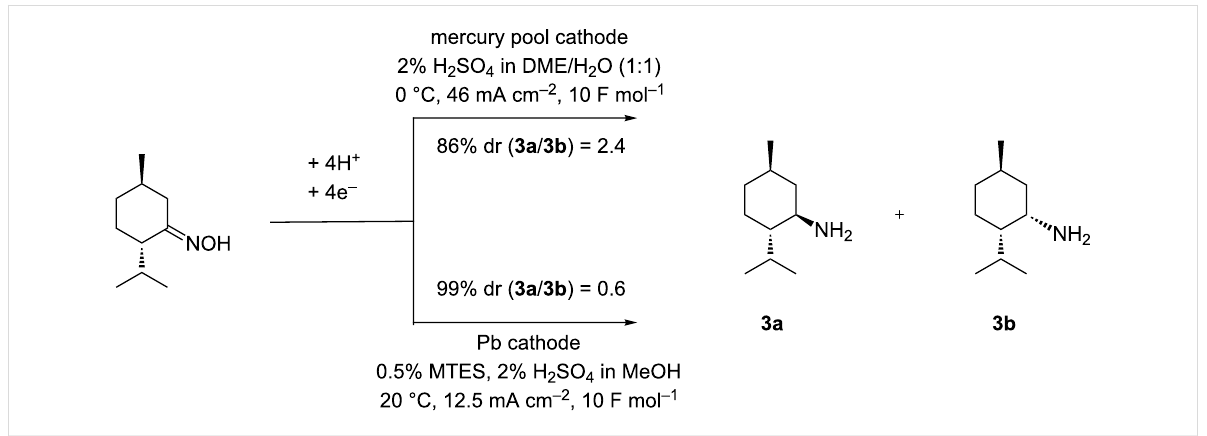
Scheme 4: Influence of the cathode system onto the stereoselectivity of the reduction of (1 R ,4 S )-menthone